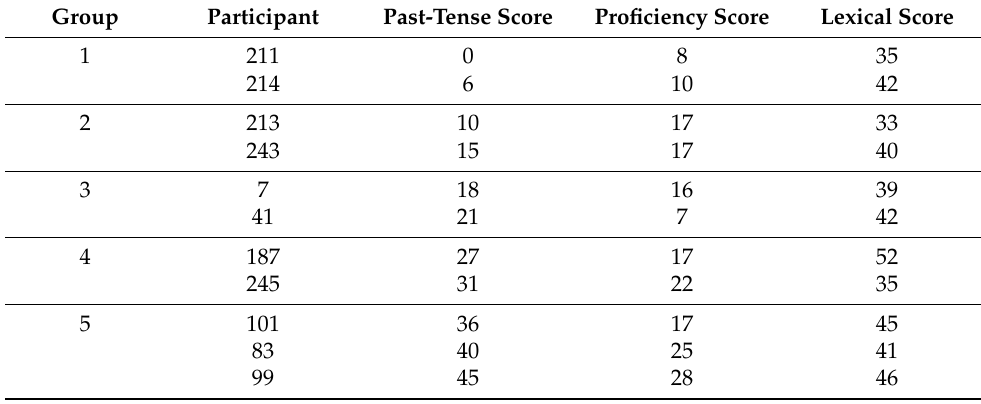
Table 2. Test scores of the participants in the cross-sectional sample.